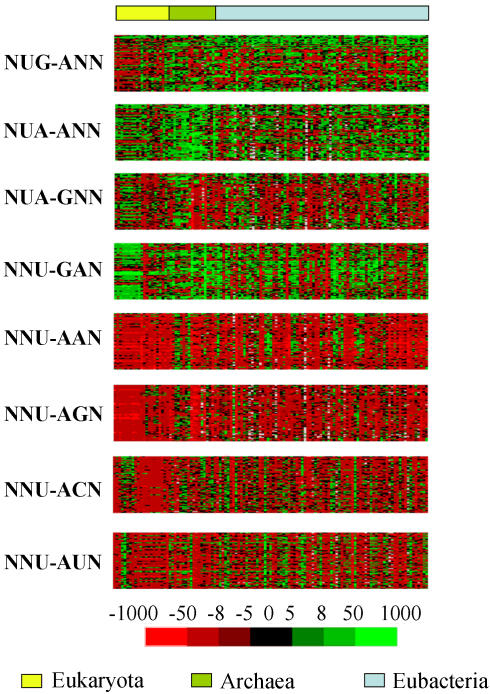
Genome dinucleotide bias has a strong influence on codon-pair context.Since the most generalized negative codon-pair context rule detected corresponds to the general expression NNU3-A1NN, which includes the out-of-frame translation termination contexts NNU3-A1A2N and NNU3-A1G2N, other out-of-frame context terminators were analyzed separately. For this, the adjusted residuals of such contexts were included in an ORFeome comparison map. It was clear that NNU3-A1GN and NNU3-A1AN were indeed the most negative codon-pair contexts bearing out-of-frame stops, followed by NUA3-G1NN. The other groups of contexts tested did not generate codon-pair context rules, although some of them contained the strongly repressed UpA dinucleotide. The hypothesis that rejection of codon-pair contexts containing out-of-frame stop codons, namely NNU3-A1A2N and NNU3-A1G2N evolved to avoid premature termination was partially contradicted by the existence of similar patterns of NNU3-A1NN-type contexts that do not include any out-of-frame stops, namely NNU3-A1C2N and NNU3-A1U2N. ORFeomes were arranged in the map by domain of life (Eukaryota, Archaea and Eubacteria from left to right) and sorted as shown in Figure S2. Adjusted residuals are colored in the maps so that green cells correspond to preferred and red cells to rejected contexts.